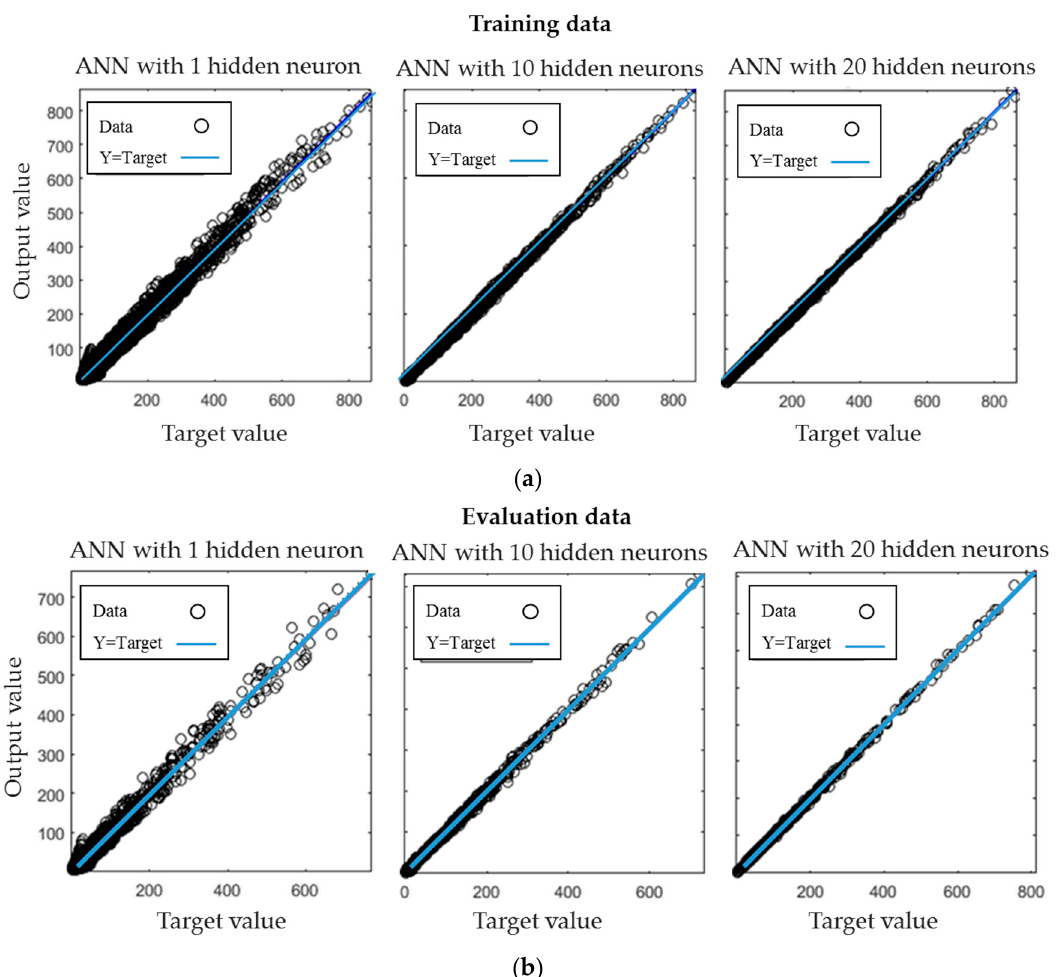
Figure 8. Relation between the target values and output values of the ANN with 1, 10 and 20 hidden neurons. ( a ) Using the training data; ( b ) using evaluation data. Table 4. Cross-validation of the ANN with 20 hidden